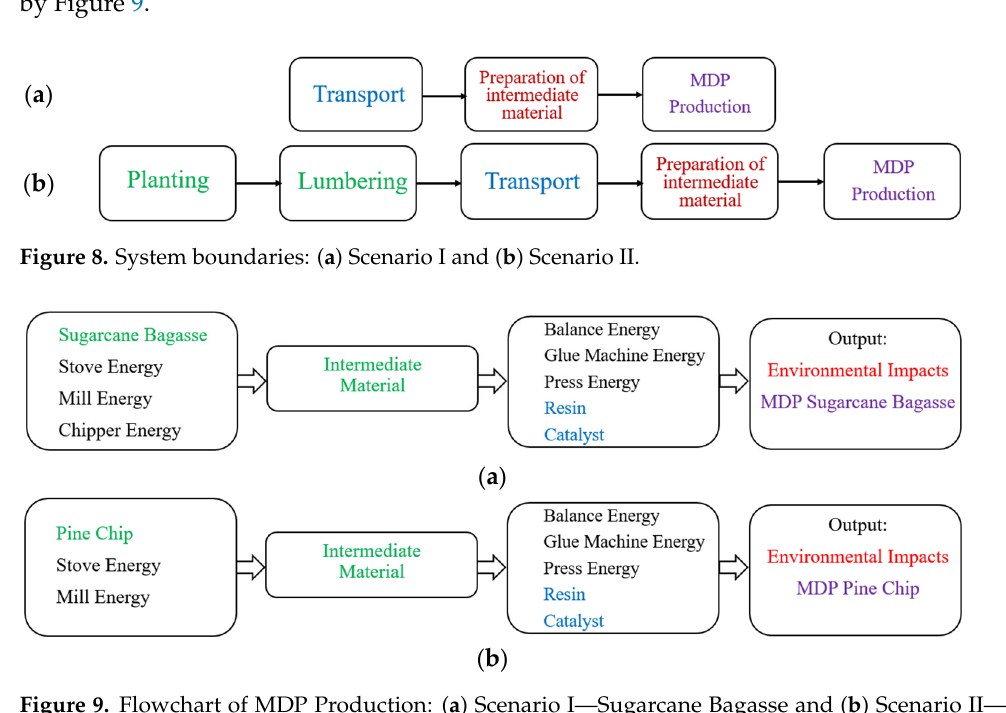
Figure 9. Flowchart of MDP Production: ( a ) Scenario I—Sugarcane Bagasse and ( b ) Scenario II— Pine Chip.